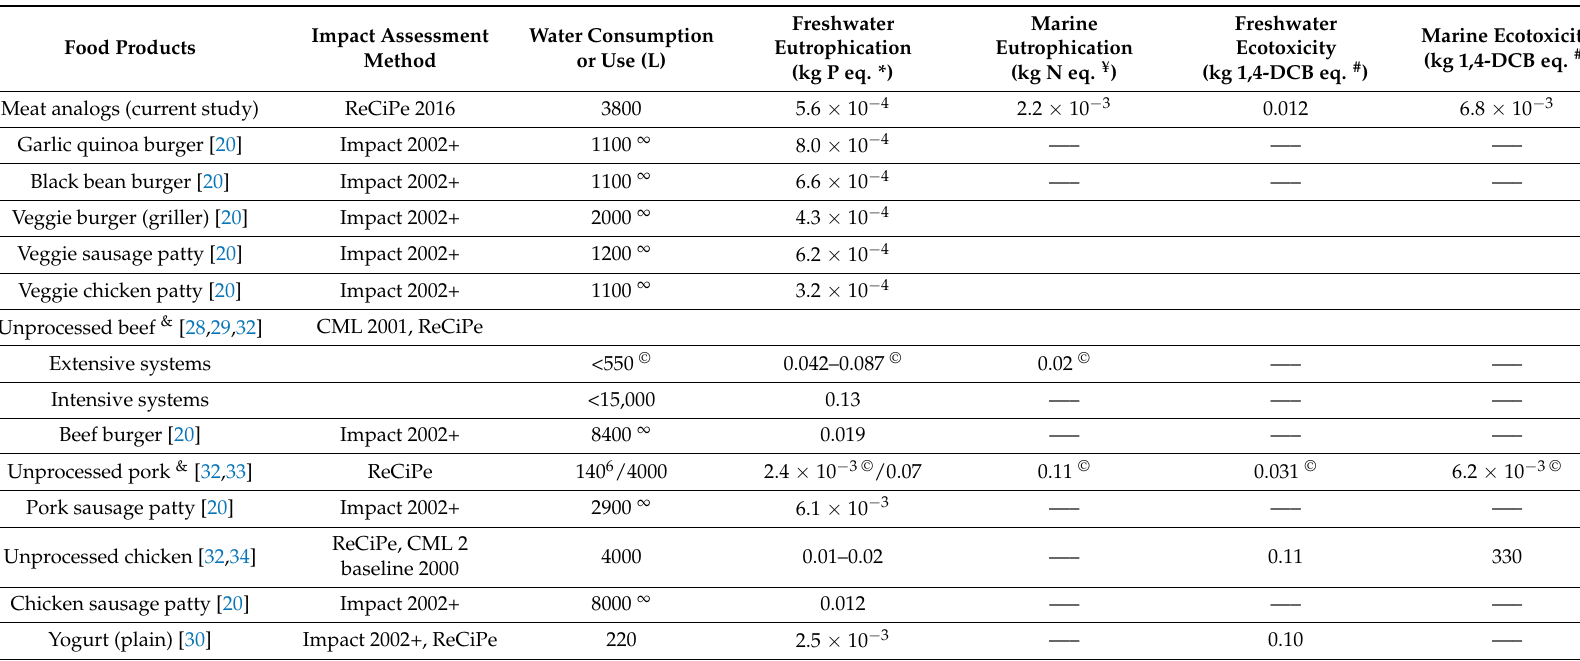
Table 3. Five life cycle assessment indicators associated with generating one kilogram (as the functional unit) of the products indicated. Food